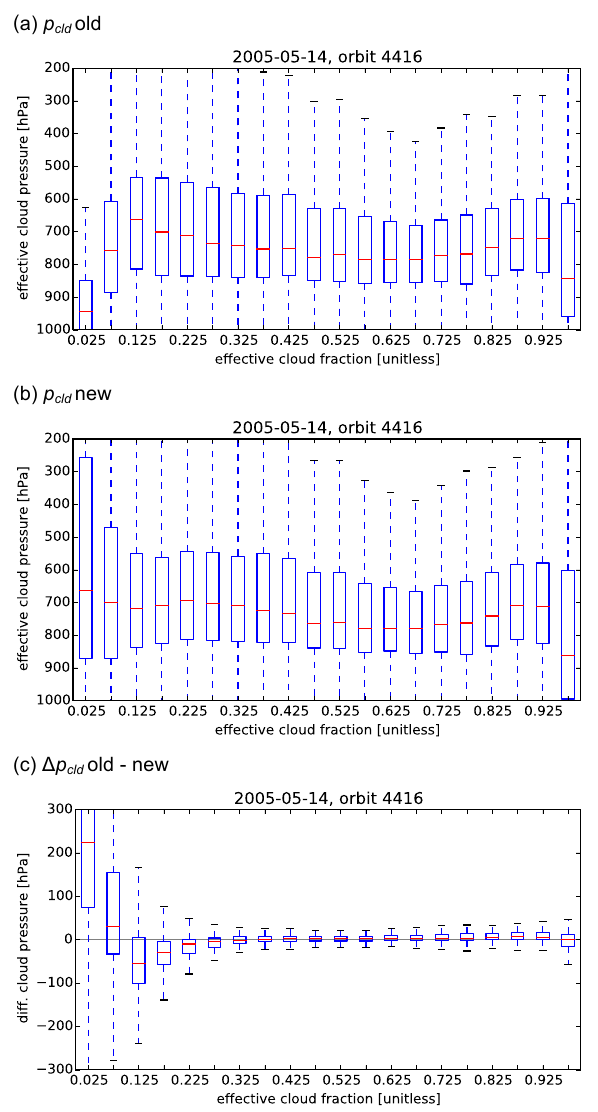
Figure 7: Box-whisker plots of the effective cloud pressure as a function of the effective cloud fraction. The top plot is for the old LUTs, the middle for the new LUTs and the bottom plot for the difference of old minus new.